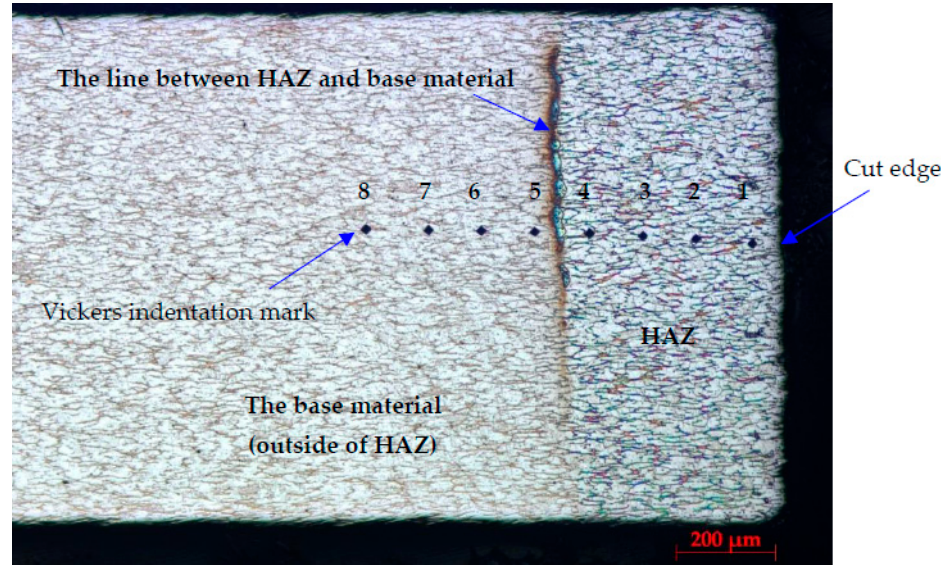
Figure 3. Indentation points for measuring microhardness (cross-section).